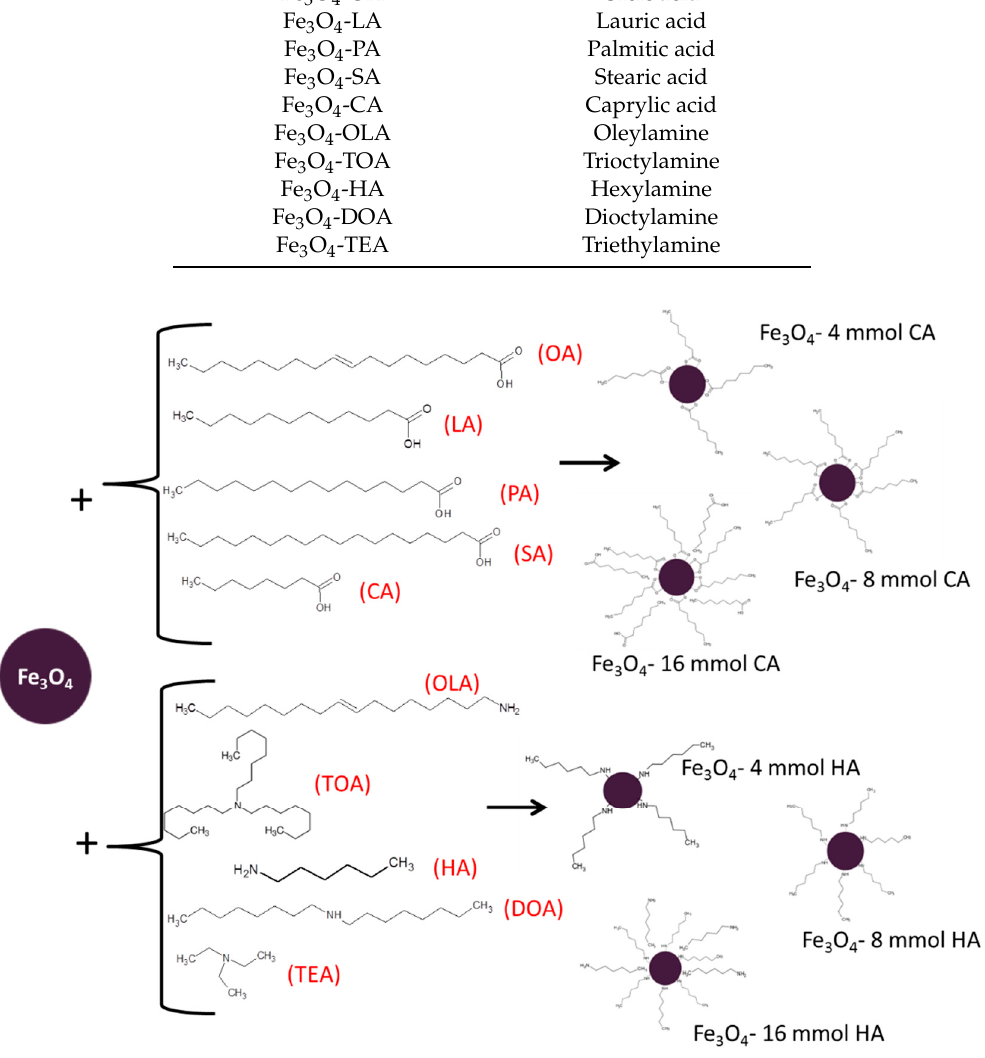
Figure 1. Schematic presentation of the coating by fatty acids and amines. Table 1. Summary of types of used surfactants together with their abbreviated names.